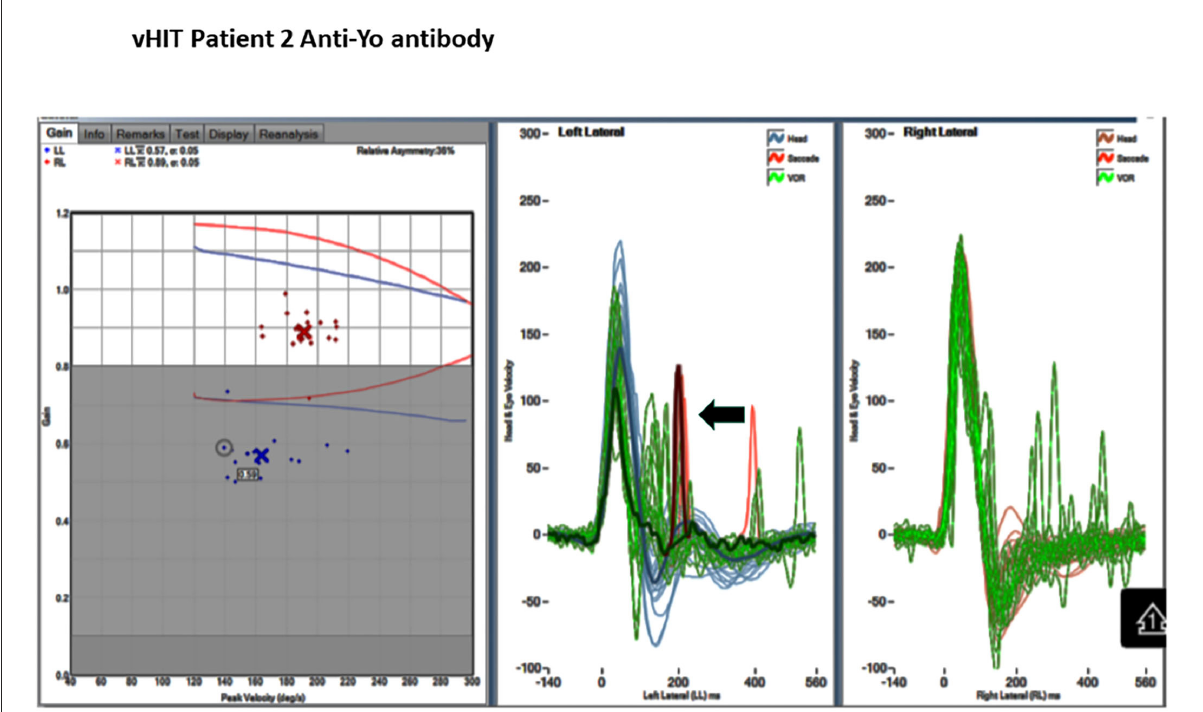
FIGURE3 Video head impulse test (vHIT) of the horizontal VOR. Gain: 0.57 right and 0.89 left. Note catch-up saccade. There is a catch-up saccade 100m sec after the end of the left head impulse (arrow).